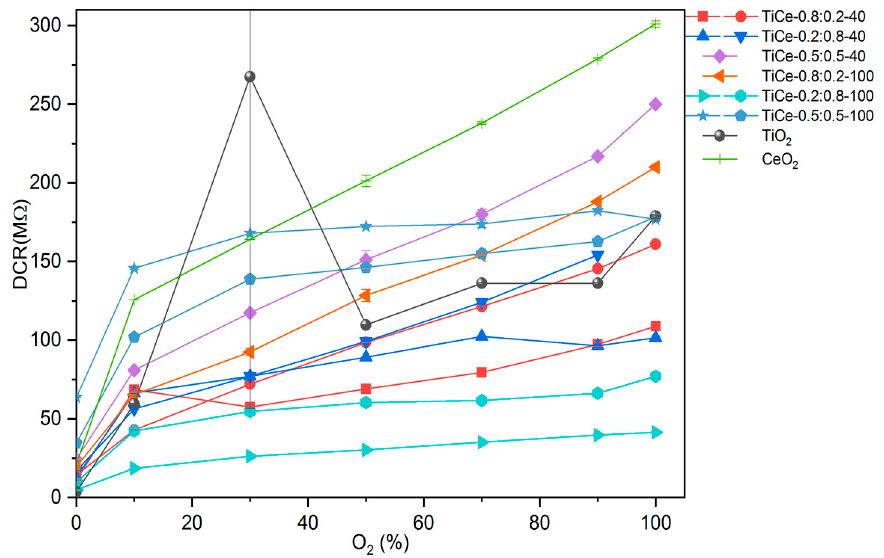
Figure 15. Measurements of the resistance of the mixed and pure oxides at different volumetric concentrations of O 2 at a temperature of 320 °C.